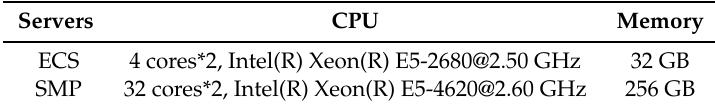
Table 7. Hardware environments.